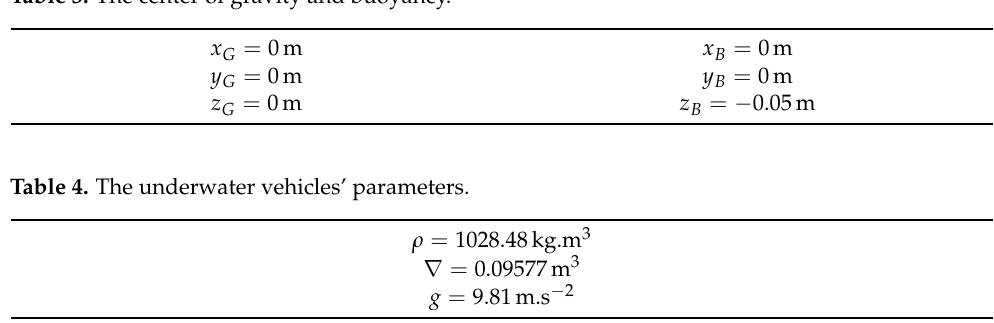
Table 3. The center of gravity and buoyancy.